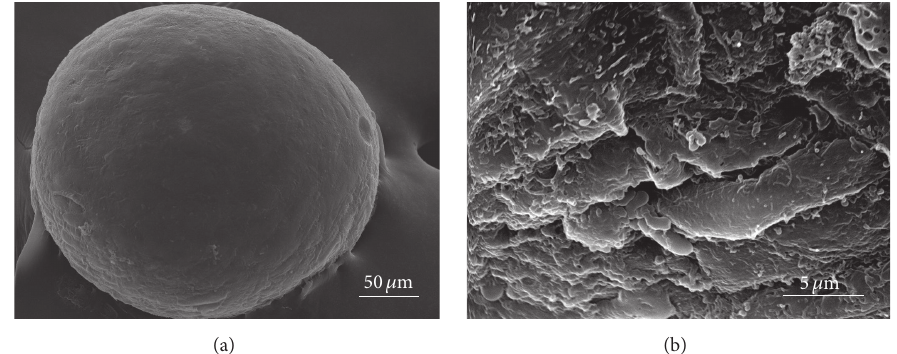
Figure 3: Electron micrographs of spheroids of MC3T3-E1 cells at 30,000 cells’ density, obtained by Scanning Electron Microscopy at different magnifications.